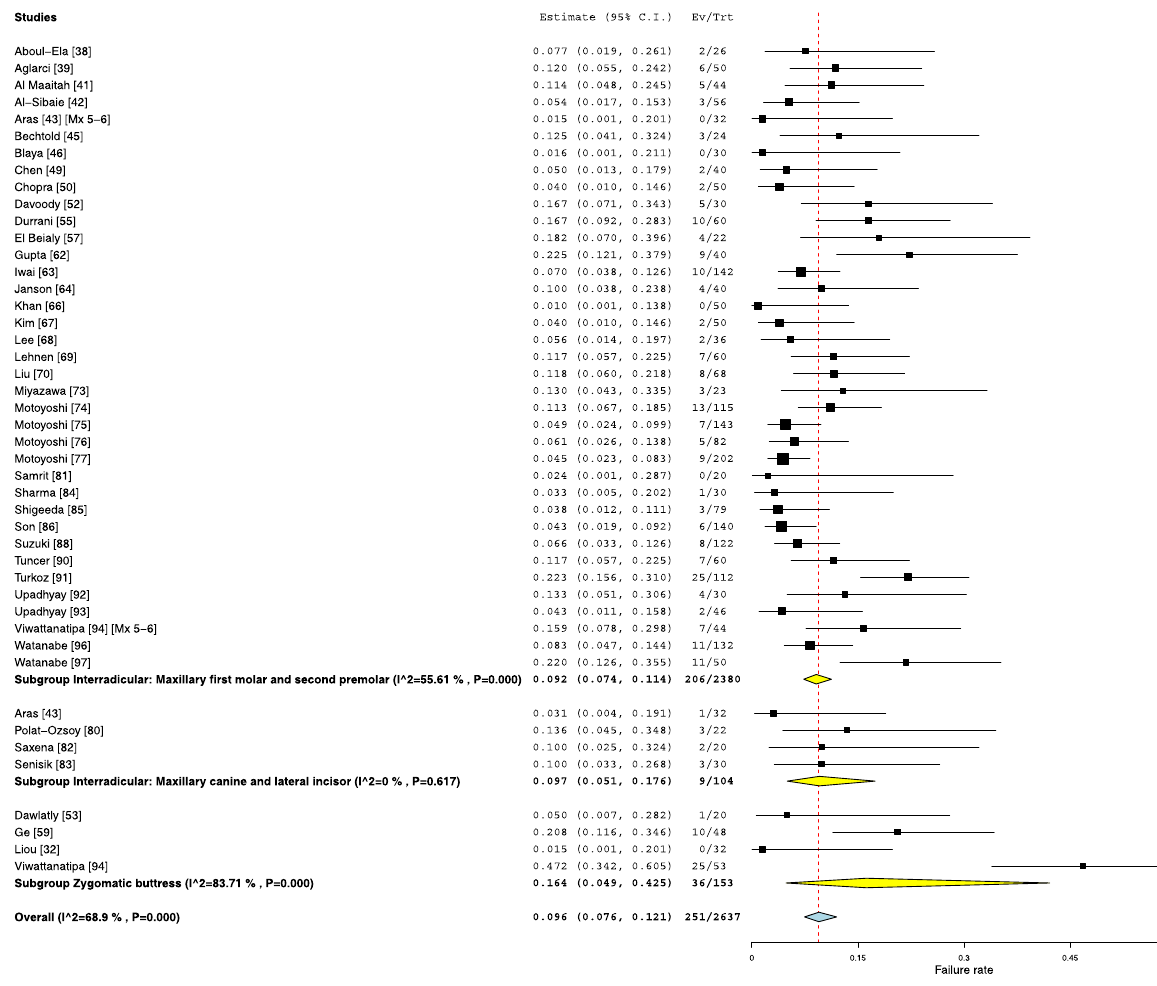
Fig. 6 Forest plot showing the failure rates for various maxillary buccal insertion sites